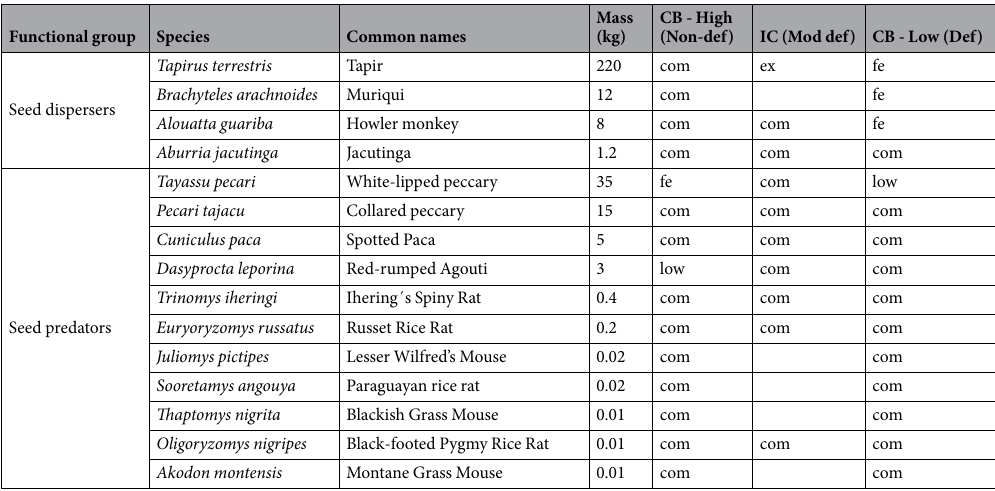
Table 1. Seed disperser and predator assemblages in the intact (Carlos Botelho, highlands – CB-High), moderately defaunated (Ilha do Cardoso – IC), and defaunated areas (Carlos Botelho, lowlands – CB-Low). ‘com’ indicates that the species is common in the area, “low” that it occurs in low density, “fe” that the species is functionally extinct, and “ex” that the species is